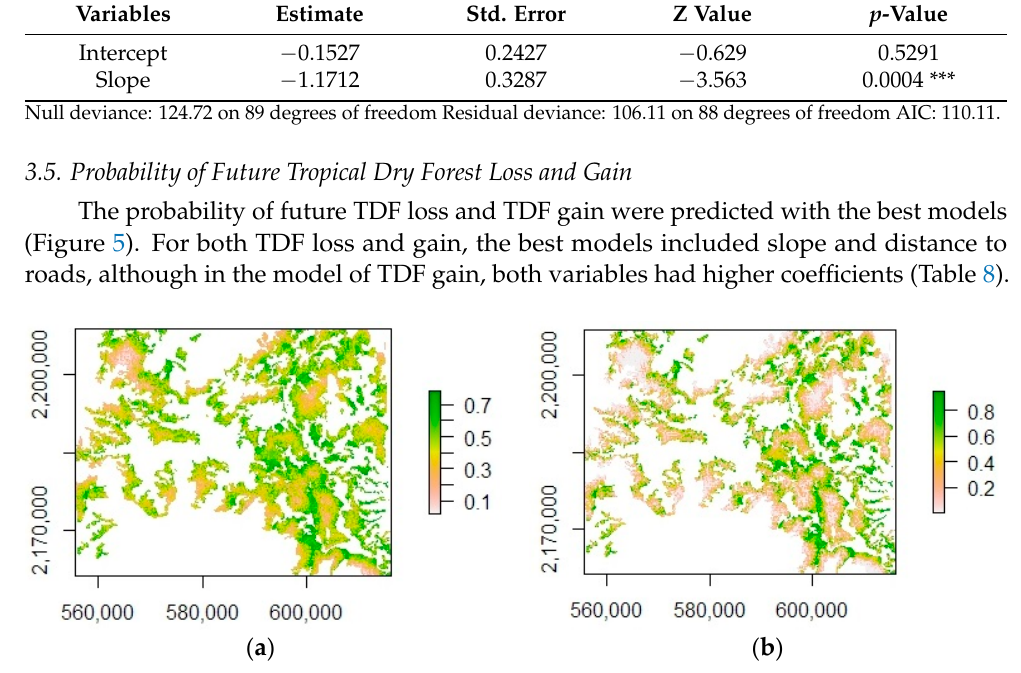
Figure 5. Probability of TDF loss ( a ) and TDF gain ( b ) predicted with the best models. ( a ) Probability of TDF loss predicted with slope and distance to roads. ( b ) Probability of TDF gain predicted with slope and distance to roads.